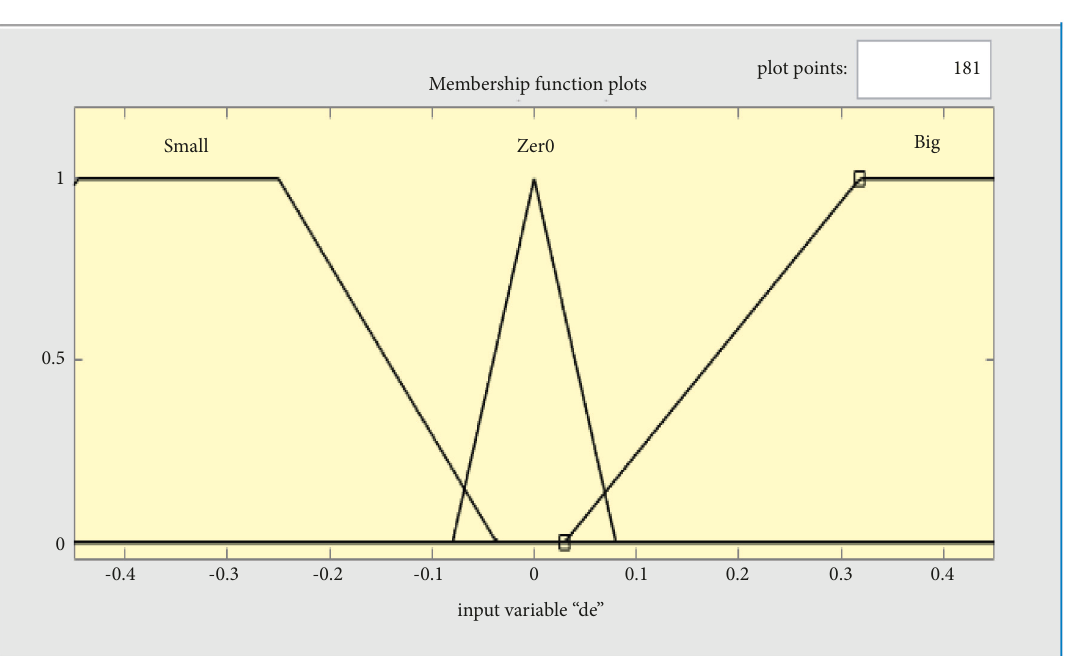
Figure 24: The 2 nd input ( ∆ e) Membership Functions.